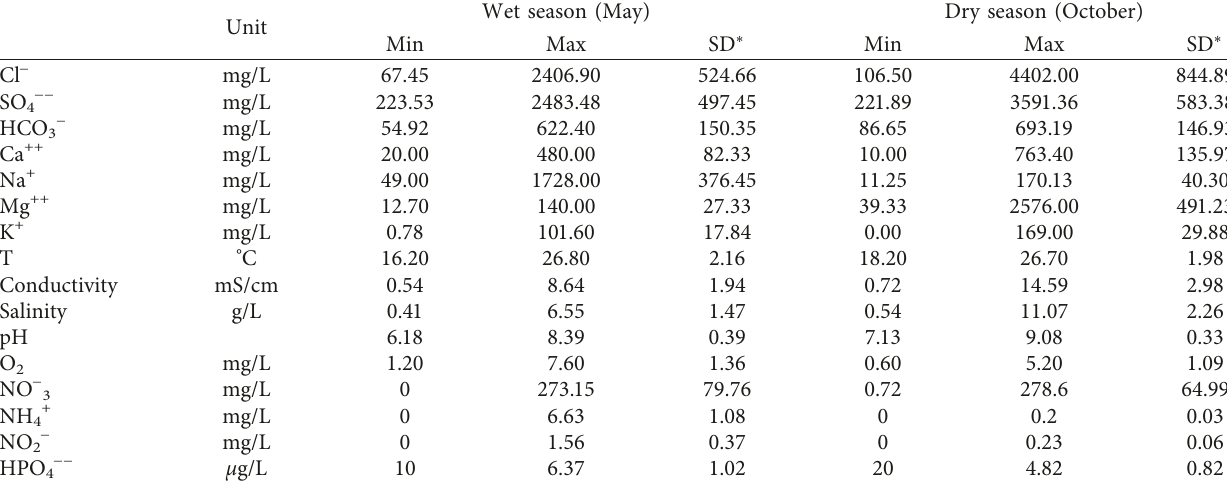
Table 2: Statistical summary of hydrochemical parameters of the study